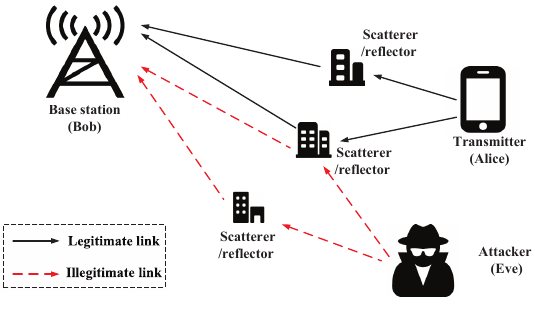
Figure 1. System